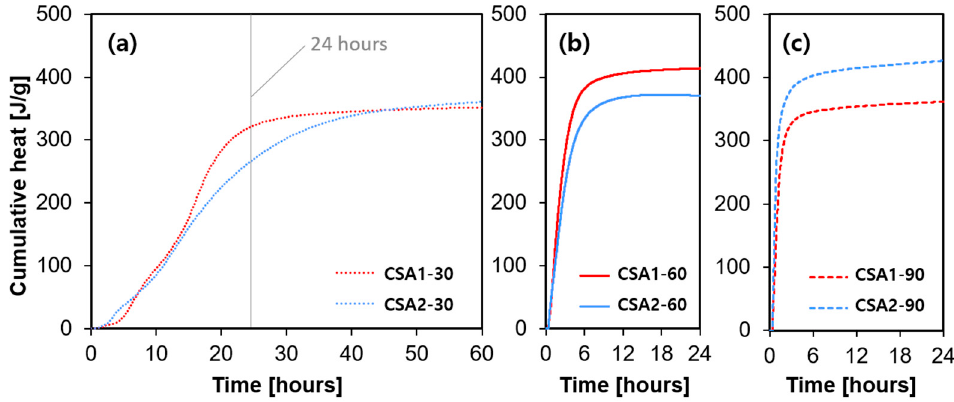
Figure 7. Cumulative heat releases of each samples cured at ( a ) 30 °C, ( b ) 60 °C and ( c ) 90 °C.